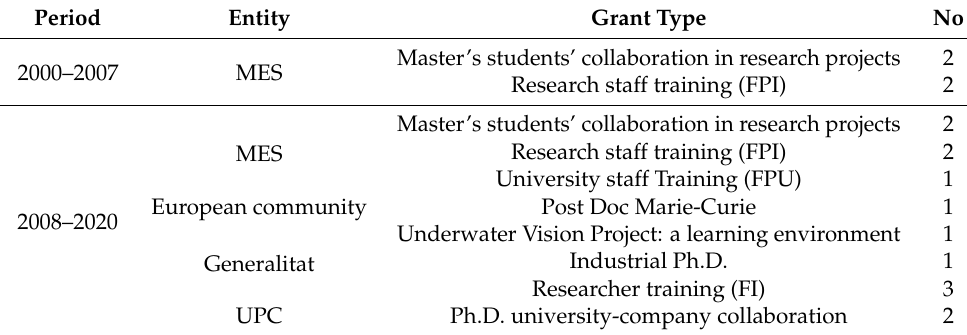
Table 9. Collaboration in the training of Master’s/Ph.D.